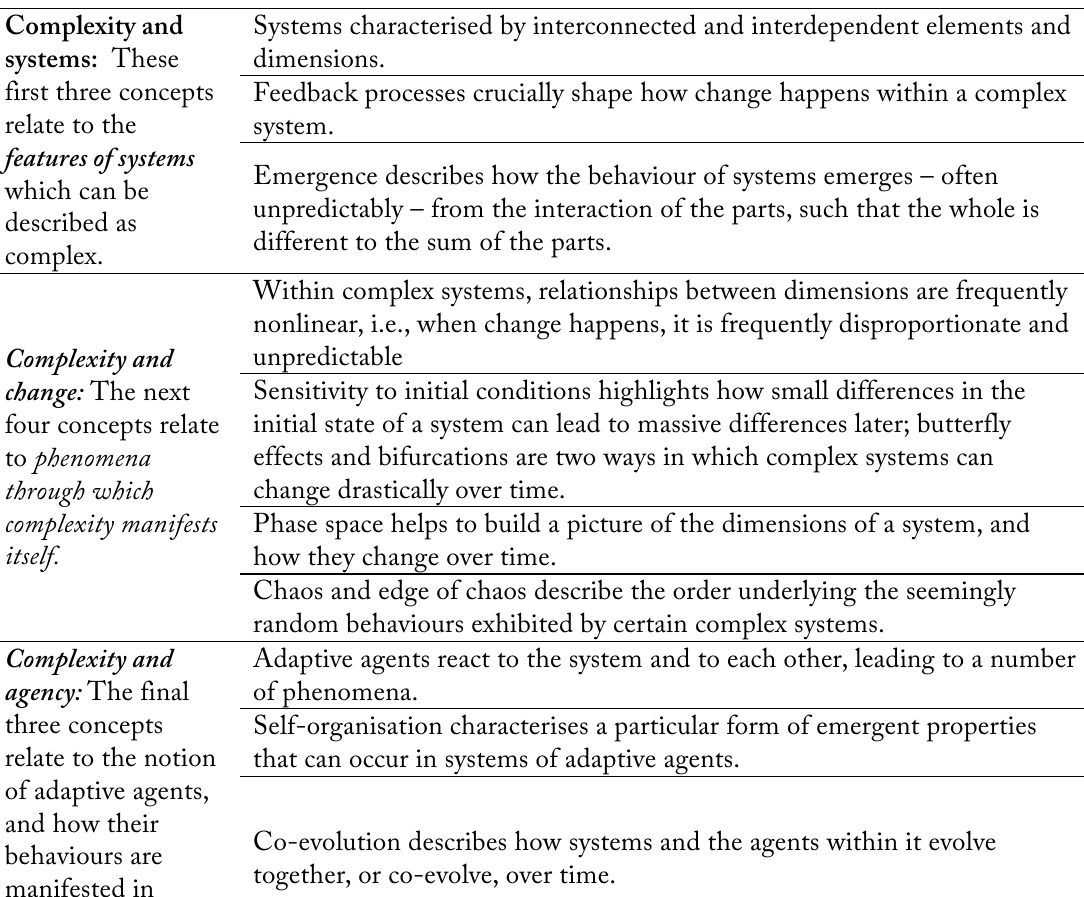
Table i: Key concepts. Source : Adapted from Ramalingham and Jones